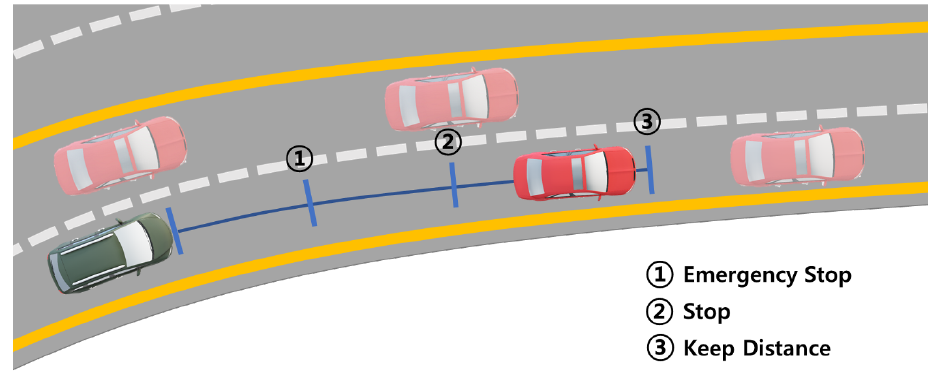
Figure 15. Case of long-control